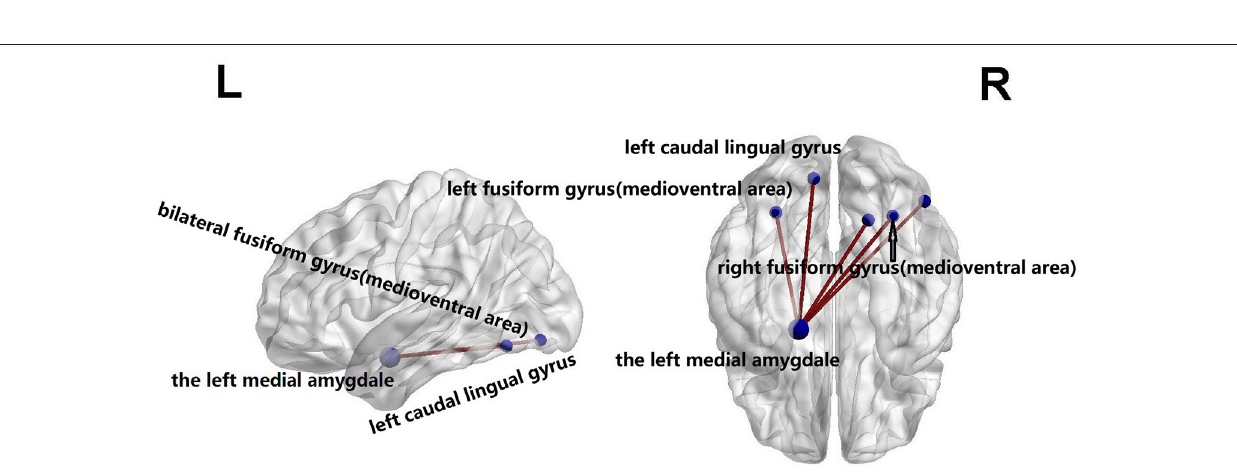
FIGURE 3 | Compared with sporadic PD, familial PD group showed a decreased functional networks strength according to the network-based statistical (NBS) analysis method, under a liberal primary threshold of ( p < 1 × 10 − 3 ). The line represents the functional connection.